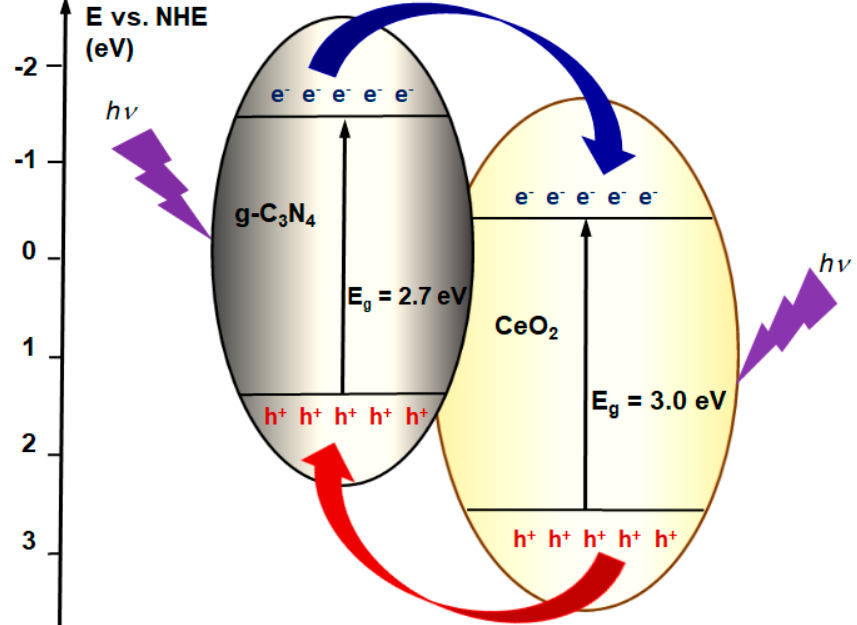
Figure 5. A schematic diagram of h + / e − pair separation in CeO 2 composites with graphitic carbon nitride (g-C 3 N 4 ) in a type II heterojunction.